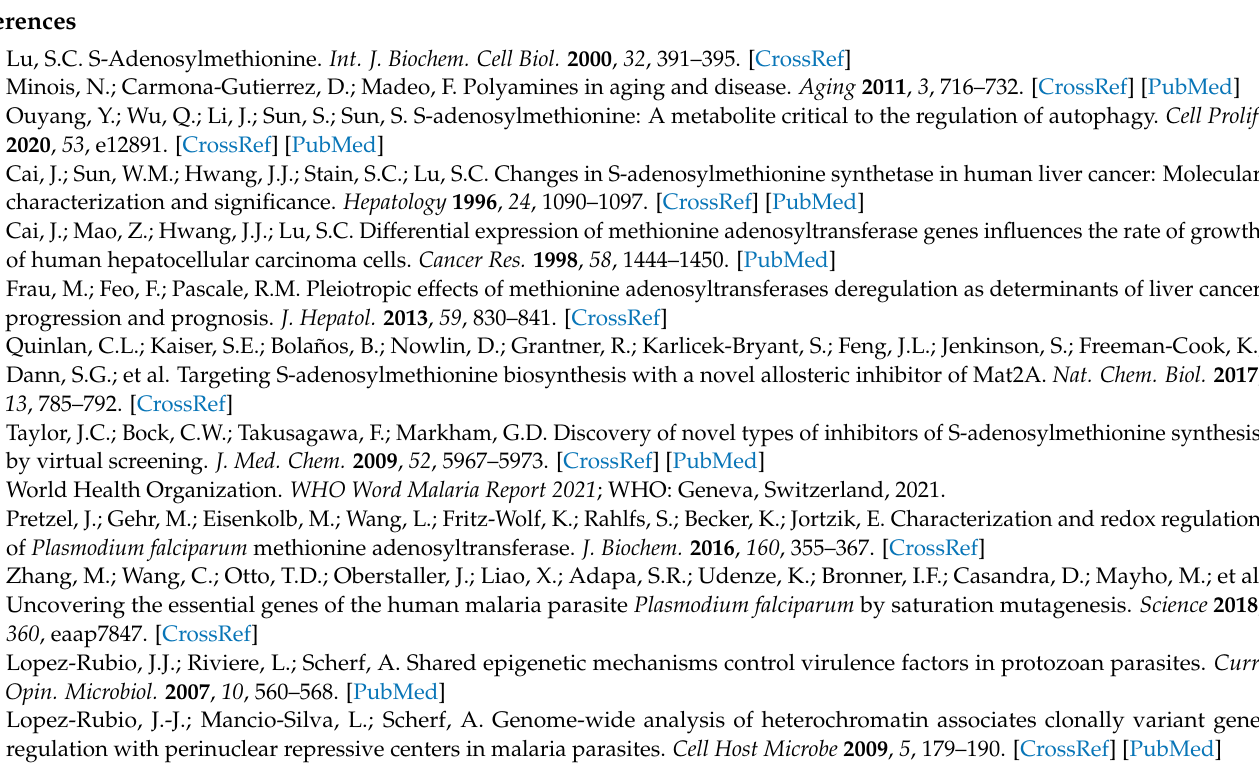
Table S2. Combined list of the putative 1114 interactors of Pf SAMS; Table S3. Summary of the GO enrichment analysis; Table S4. List of interactors sorted by cluster; Table S5. Selected interactors of Pf SAMS sorted by